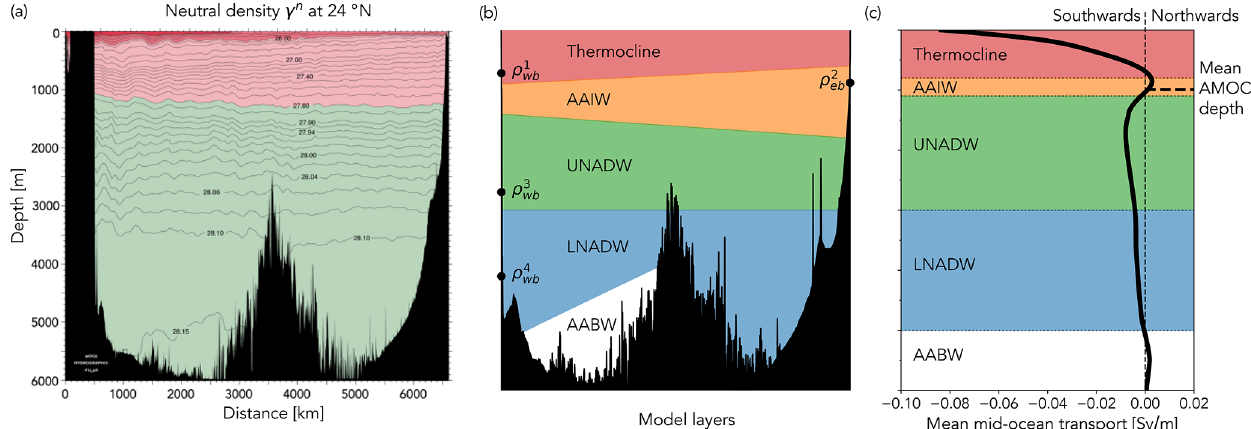
Figure 1. (a) World Ocean Circulation Experiment (WOCE) North Atlantic A05 section of neutral density γ n (kgm − 3 ) at 24 ◦ N, July or August 1992. From the WOCE Atlantic Ocean Atlas Vol. 3. (Koltermann et al., 2011). (b) Schematic of four dynamic layers to be represented within the regression model by density anomalies at the western and eastern boundaries at a depth within each layer. The density anomalies are represented by the circular markers. (c) Profile of RAPID-estimated mean mid-ocean transport and the resulting northward and southward layer transports. Mean AMOC depth is around